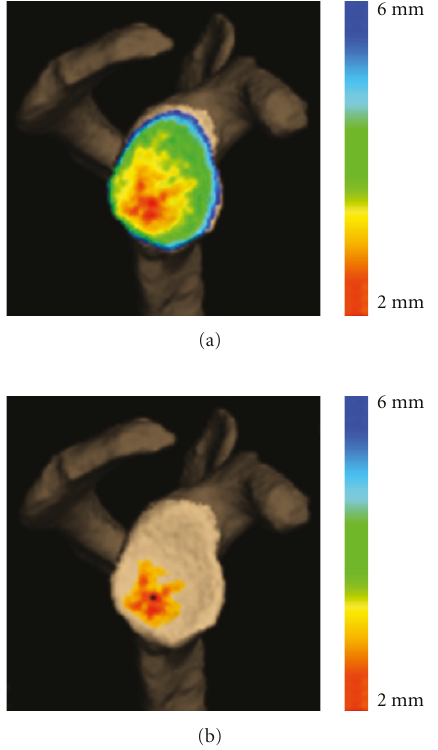
Figure 2: (a) Colormap of the minimum distance between the glenoid and humerus for a single frame of data. (b) The contact center location (indicated by the black dot) was calculated as the centroid of the closest 200mm 2 region between the humerus and glenoid.